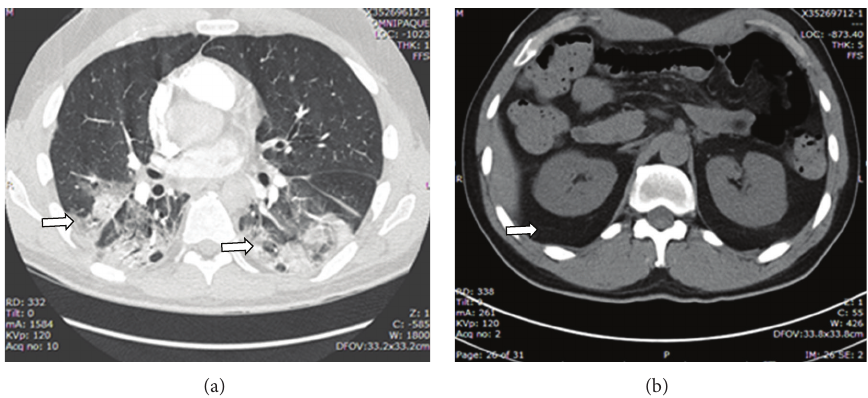
Figure 3: (a) CT chest/abdomen/pelvis. No evidence for pulmonary embolism. Patchy peribronchiolar consolidations are worsened in the right upper lobe, right lower lobe, and left lower lobe (see arrow). (b) No abdominal masses/hemorrhage is seen (see arrow).